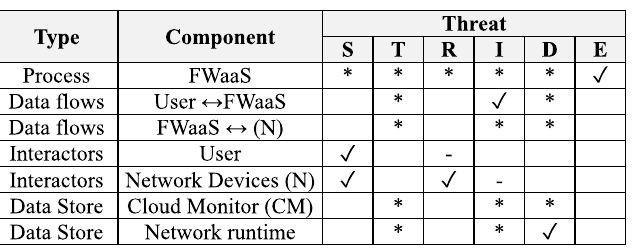
Table 15 Summary of the security analysis for the FWaaS